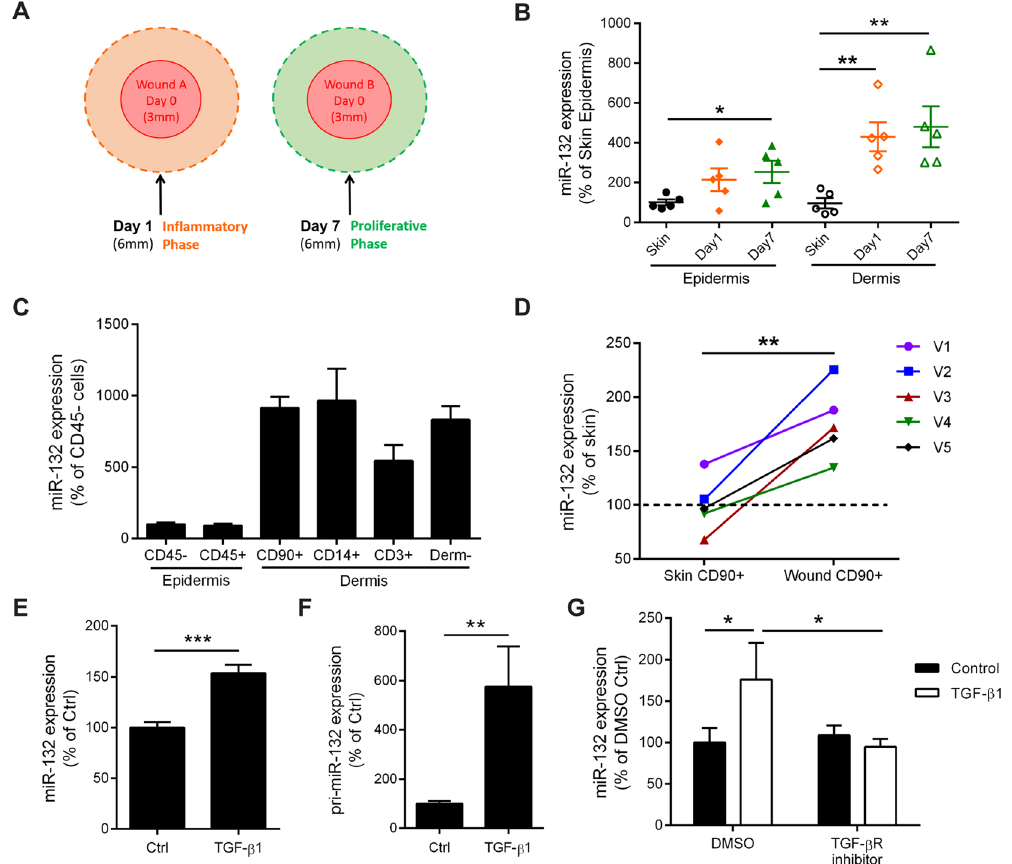
Figure 1. Expression and regulation of miR-132 in wounds. ( A ) The intact skin (Day 0), Day 1 and Day 7 wounds were collected from healthy donors. ( B ) MiR-132 expression was analyzed in the epidermis and dermis of the biopsies from donor 1–5, which were separated by laser capture microdissection. ( C ) QRT-PCR analysis of miR-132 expression in the cells isolated from the Day6 wounds of 5 donors, including CD45- and CD45 + cells from epidermis, and CD90 + , CD14 + , CD3 + and CD90-CD14-CD3- (Derm-) cells from dermis. ( D ) QRT-PCR analysis of miR-132 expression in dermal CD90 + cells from intact skin and Day6 wounds. V1–5 indicate 5 healthy volunteers. QRT-PCR analysis of miR-132 ( E ) or its primary precursor pri-miR-132 ( F ) in HDFs treated with 10 nM TGF- β 1 for 48 hours (n = 3). ( G ) The TGF- β receptor inhibitor SB431542 was applied 15 minutes before adding TGF- β 1 to HDFs, and miR-132 expression was analyzed 48 hours later (n = 3). The data are presented as mean ± s.e.m. in ( B , C ), as mean ± s.d. in ( E-G ). * P < 0.05, ** P < 0.01 and *** P < 0.001 by Student’s t